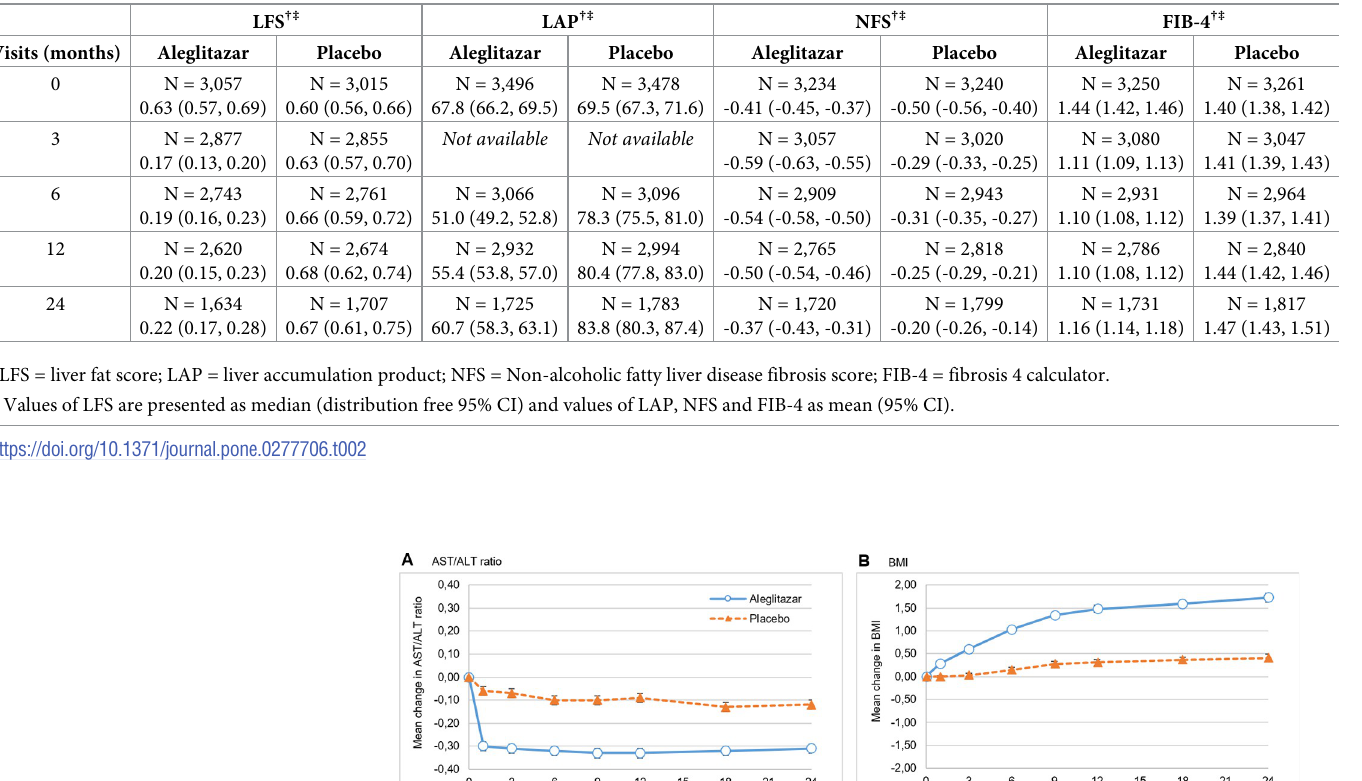
Table 2. Changes in absolute values of non-invasive tests over time.